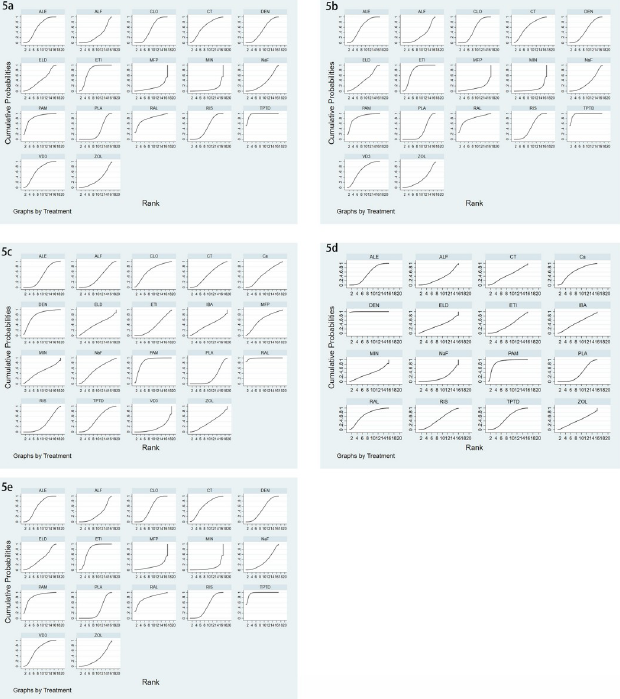
Fig 5. The surface under the cumulative ranking curve (SUCRA) ranking chart. (5a) Incidence of vertebral fractures, (5b) Incidence of non-vertebral fractures, (5c) Mean percentage change of BMD of LS from baseline, (5d) Mean percentage change of BMD of TH from baseline, (5e) Serious adverse events.